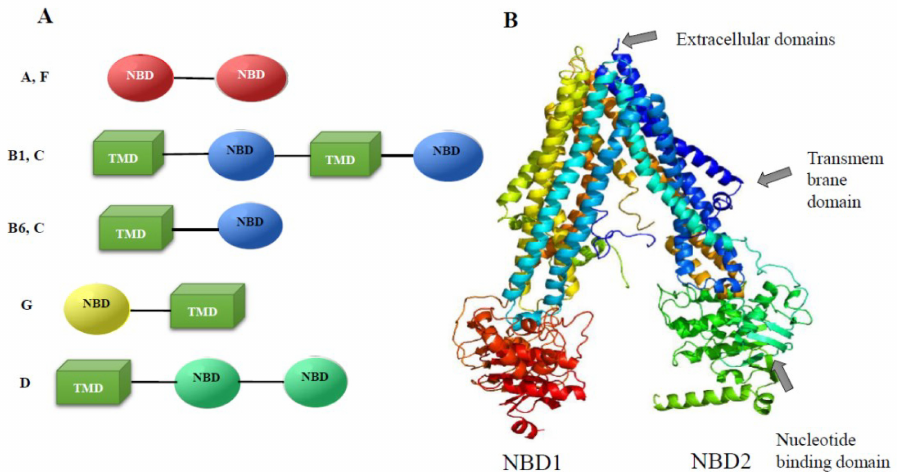
Figure 4. Structure of conserved domains of O. felineus ABC proteins. ( A ) The structure of ABC proteins is presented. TMD, transmembrane domain; NBD, nucleotide-binding domain. ( B ) The Pgp4 3D model (Phyre2 multi-matrix simulation). The (rainbow-colored) model was built using Phyre 2 multi-matrix modeling. The matrices selected by the Phyre algorithm for modeling were P-gp from C. elegans (4F4CA) and P-gp1 from Mus musculus (3G5U). The structure of a region of 1202 amino acid residues (95% of the P4 sequence) was modeled at a 100.0% match, although a region of 45 amino acid residues (aa 612–656) was modeled ab initio at a low